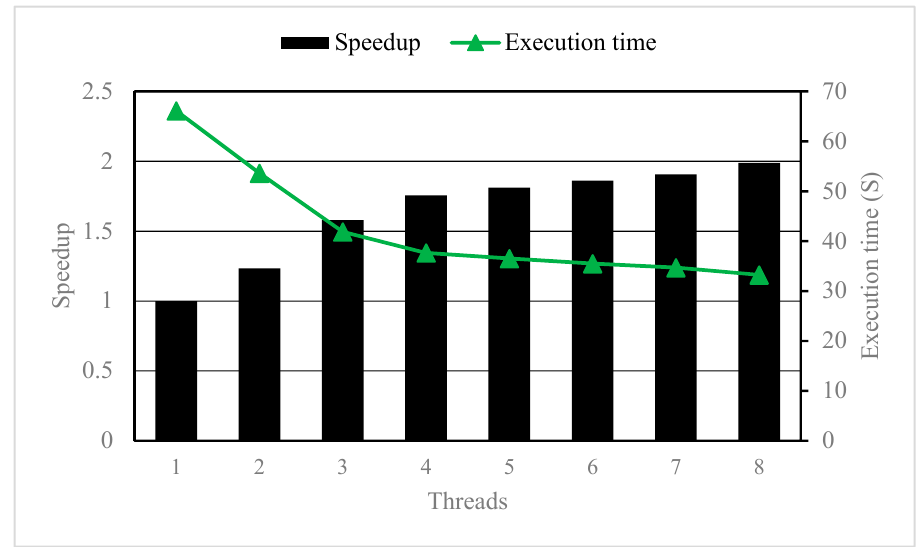
Figure 9. The Speedup and execution time with different number of threads when parallelizing the I loop.